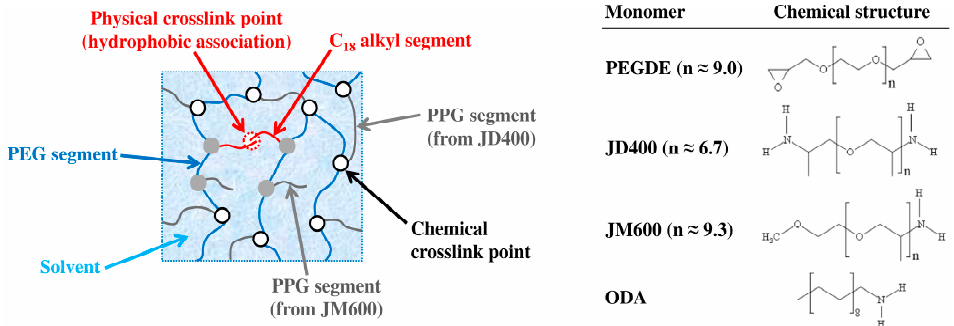
Figure 2. Schematic view of the structure of a HM hydrogel and chemical structure of the monomers.